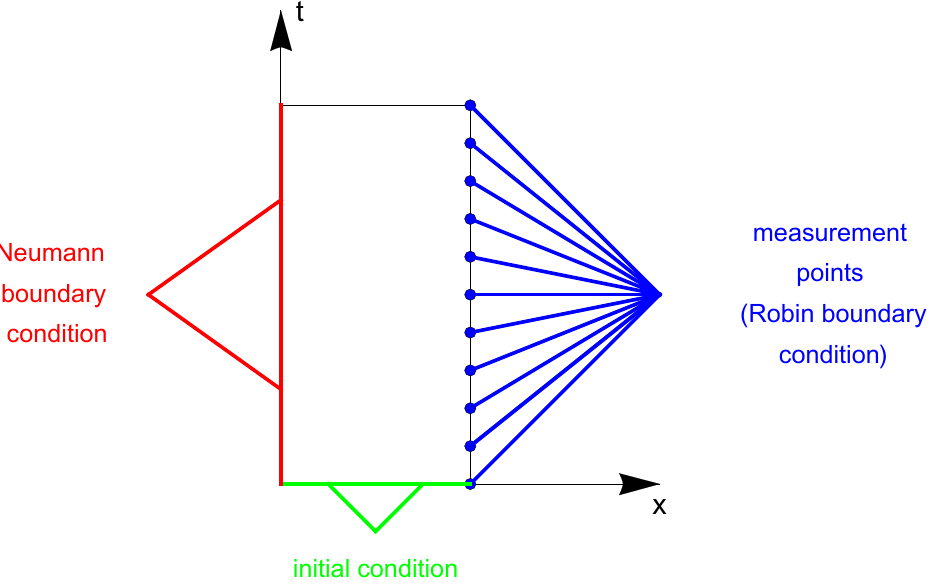
Figure 1. Considered area with marked measuring points (a fragment of the boundary with Neumann boundary condition is marked in red, a fragment of the boundary with Robin boundary condition is marked in blue, and a fragment of the boundary with initial condition is marked in